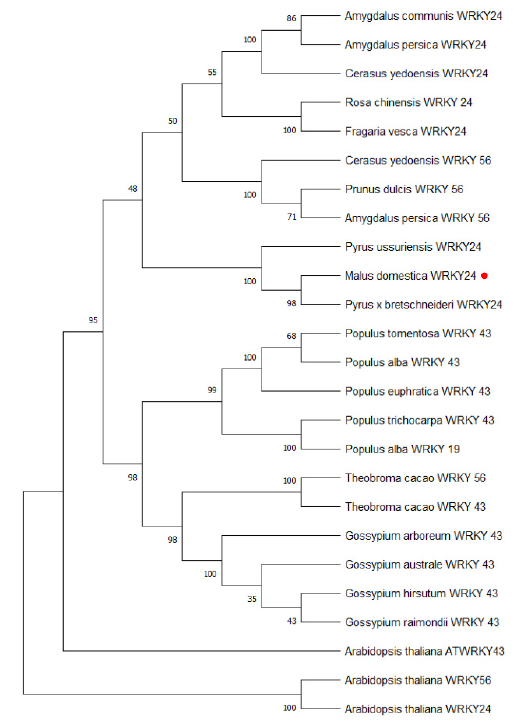
Figure 6. Phylogenetic tree of MdWRKY24 and WRKY proteins of other species. The red dot indicates the MdWRKY24 protein.